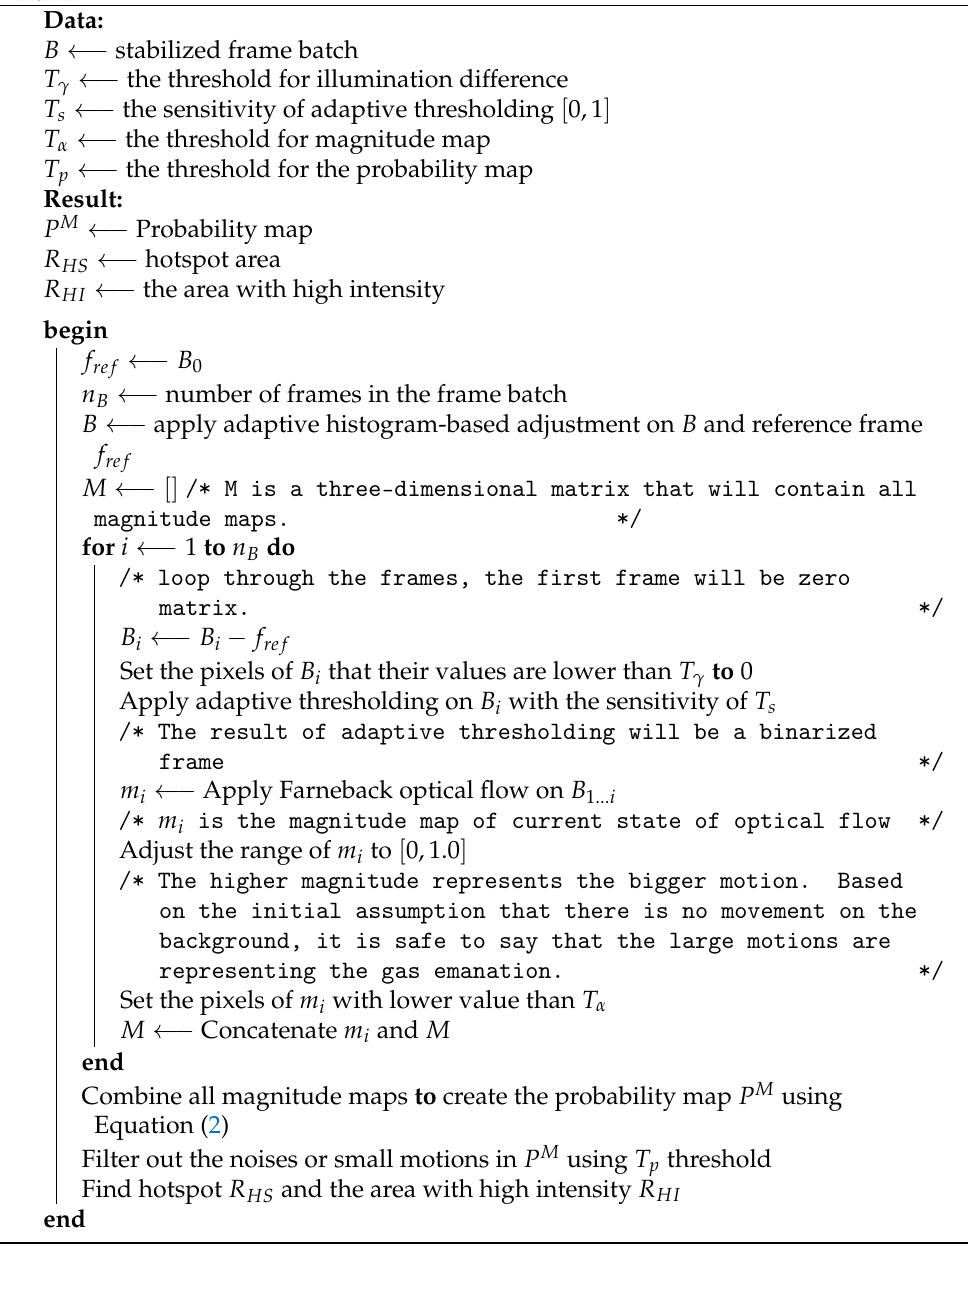
Algorithm 2: Gas emanation visually-enhancement and Gas leak detection algo-